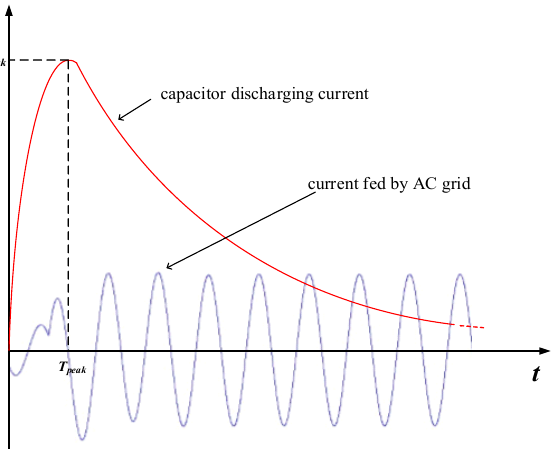
Figure 8. Decomposition of a short-circuit current after a DC-side fault without fault ride-through (FRT).